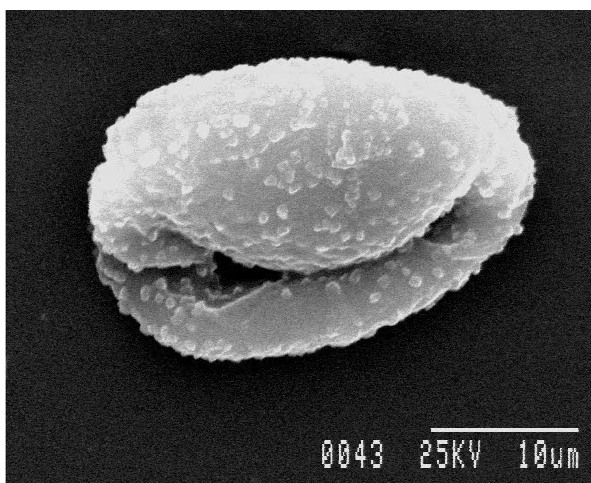
Fig. 6. X3000, showing exine pattern of Nymphaea micrantha Guillemin et Perrottet